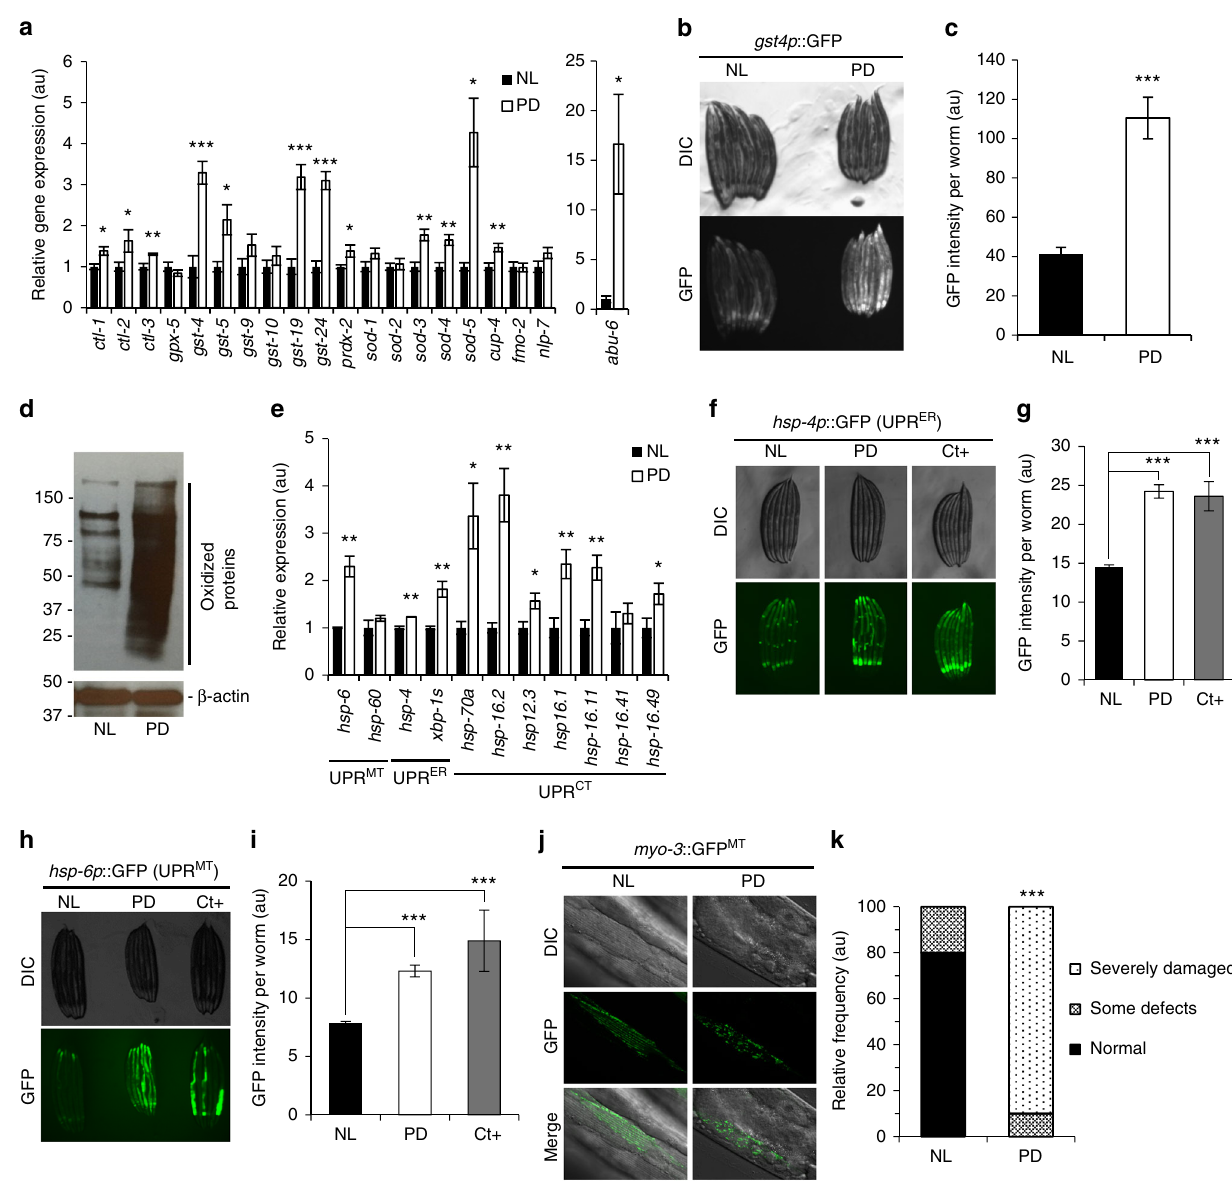
Fig. 5 Visible light creates photooxidation in C. elegans . a Relative expression levels of enzymes involved in oxidative stress response. b Microscope pictures of gst-4p ::GFP worms exposed to PD or NL condition and observed under DIC lens (top panel) or GFP fl uorescence (bottom). c Quanti fi cation of the GFP intensity from the experiment in b . d Oxyblot from worms exposed during 4 days to PD or NL. The top panel reveals DNP-derived proteins, as an indicator of oxidized proteins; β -actin antibody was used to verify equal loading (bottom panel). e Relative expression levels of mitochondrial UPR (UPR MT ), endoplasmic reticulum UPR (UPR ER ), and cytosolic UPR (UPR CT ) genes between worms exposed to PD or NL condition from hatch to D1 adult.